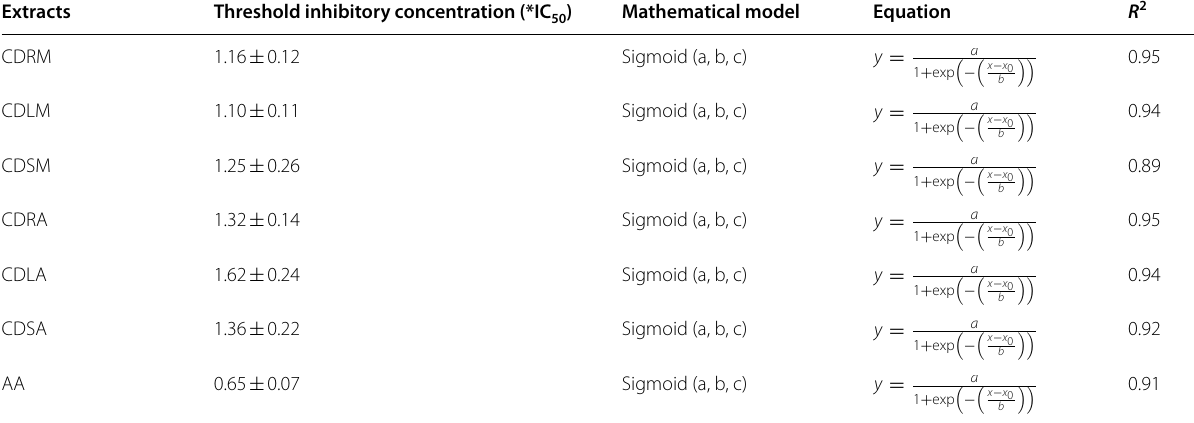
CDRM, C. dependens root methanol; CDLM, C. dependens leaves methanol; CDSM, C. dependens stem methanol; CDRA, C. dependens root aqueous; CDLA, C. dependens leaves aqueous; CDSA, C. dependens stem aqueous; AA, ascorbic acid *IC 50 is the concentration of extract or standard that scavenged 50% of the generated free radicals